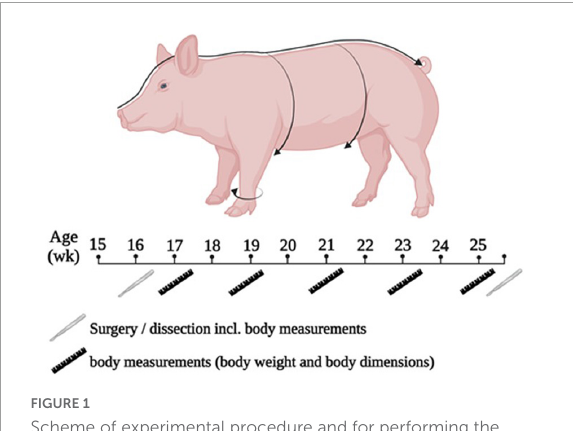
FIGURE1 Scheme of experimental procedure and for performing the measurement of body